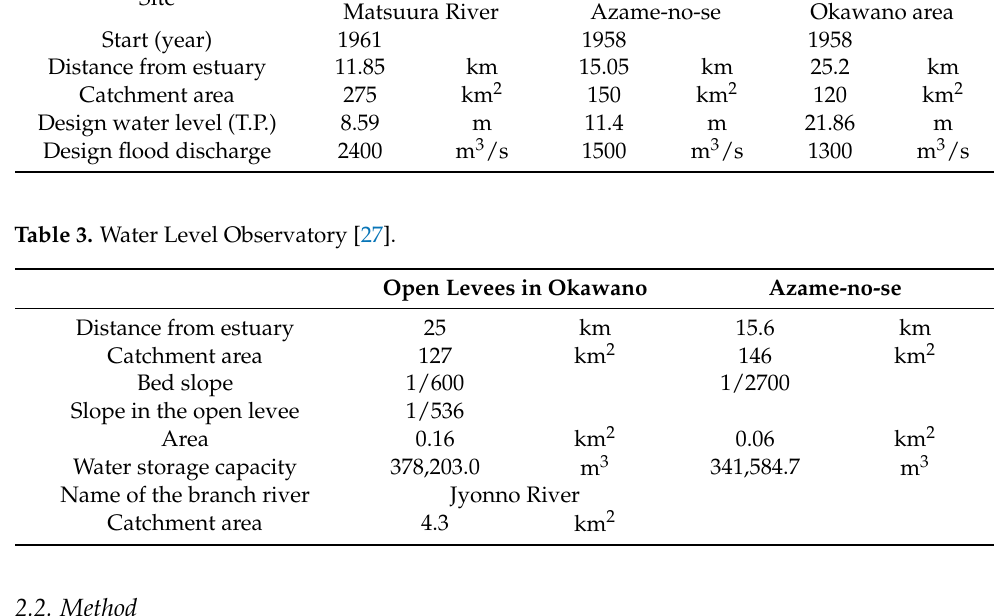
Table 2. Research sites elements [23,25]. Name of Station